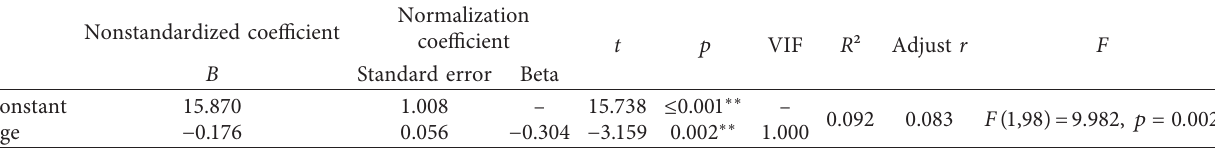
Table 9: Linear regression analysis ( n � 100).